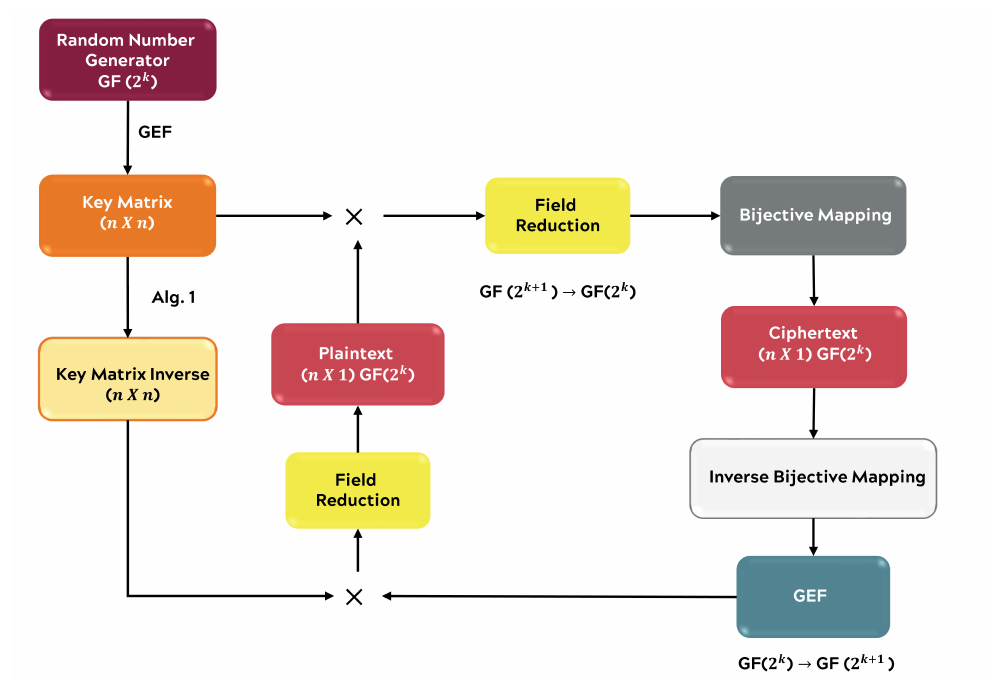
Figure 1. GEF ECB mode